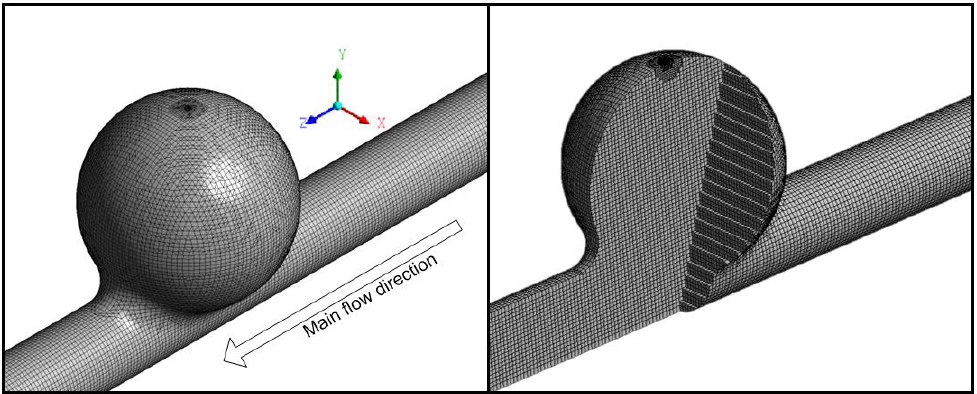
Figure 2. Detail of the mesh used in CFD